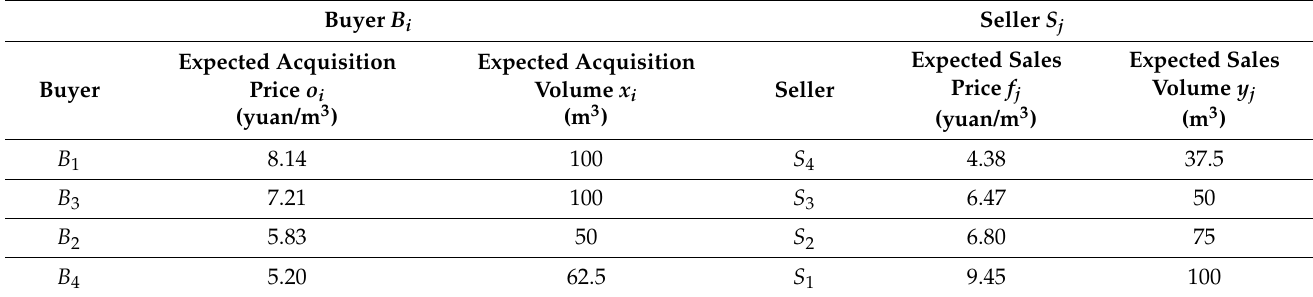
Table 1. Set of quotes ranked by expected transaction